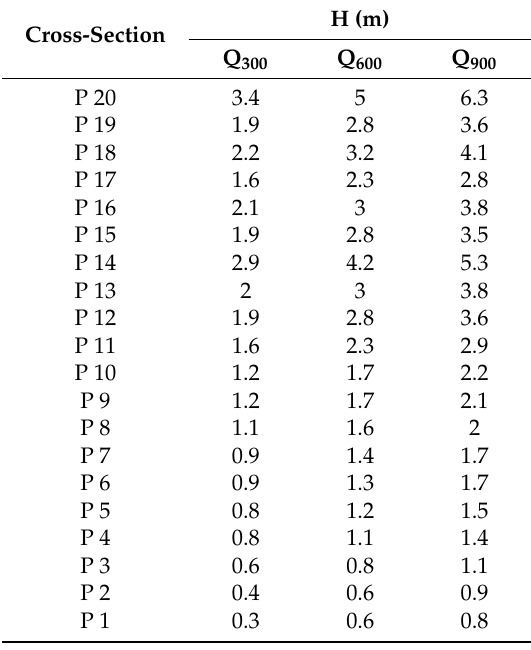
Table 3. Debris flow depth along the cross-section profiles in the Aksay Valley for the three scenarios. H Cross-Section